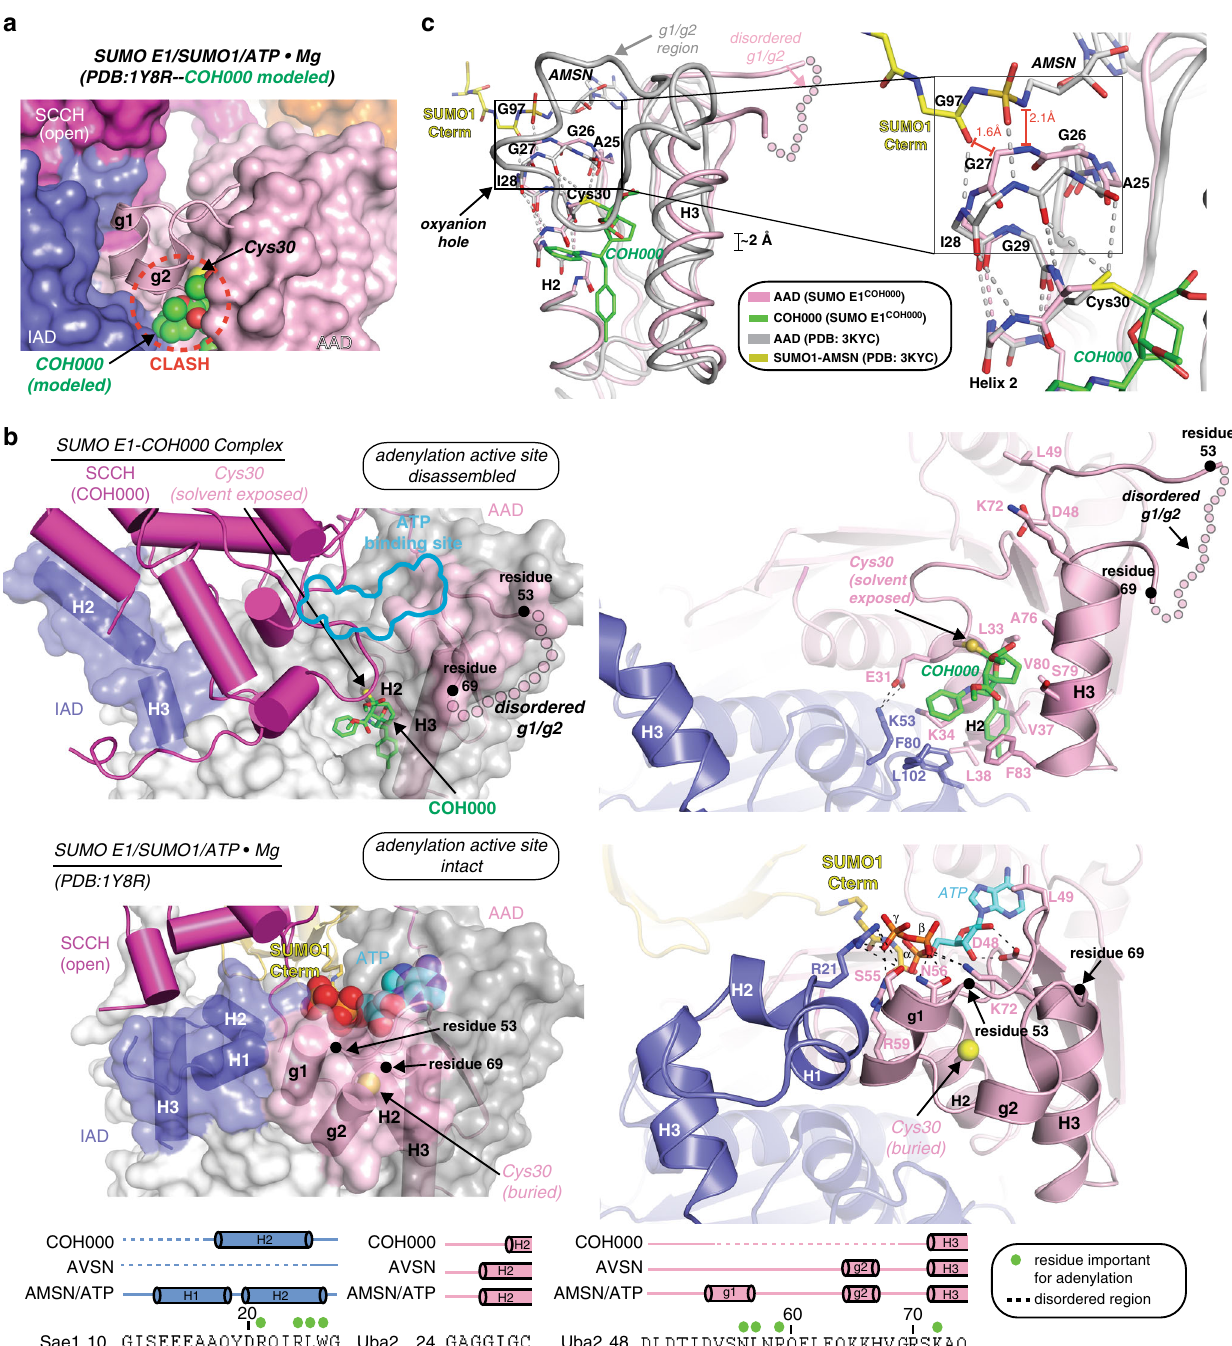
Fig. 3 Small- and large-scale conformational changes are induced in SUMO E1 upon COH000 binding. a COH000 (spheres) was docked onto SUMO E1 from the SUMO E1/SUMO1/ATP (cid:129) Mg structure (PDB: 1Y8R). SUMO E1 is shown as a surface representation with the exception of the g1/g2 region, which is shown as cartoon. The steric clash between COH000 and the g1/g2 region is highlighted by a dashed red circle. Two views of the structure, rotated by 90° about the y -axis are presented. b The SUMO E1 COH000 (top) and SUMO E1/SUMO1/ATP (cid:129) Mg (PDB: 1Y8R; middle) structures are shown in the same orientation to highlight conformational changes that occur upon COH000 binding. Regions undergoing conformational changes are colored by their domain as in Fig. 1a and the rest of the structure is colored light gray. For clarity, the SCCH domains are not shown in the magni fi ed views presented in the right panels. b (bottom) Structure-based sequence alignment of SUMO E1 active site regions undergoing conformational changes upon COH000 binding. Secondary structure for the indicated structures are shown above the sequence colored with dashed lines indicating disorder. Residues important for catalysis of adenylation are highlighted by green circles. c (left) The adenylation domains of the SUMO E1 COH000 and SUMO E1/SUMO1-AMSN (PDB: 3KYC) structures were superimposed and are shown as colored light pink and gray tubes, respectively. AMSN is an adenosine analog harboring a sulfamide group that was used to generate a nonhydrolyzable mimic of the SUMO1-adenylate intermediate 27,39 . The N-terminal half of AAD H2 is shown as sticks and the oxyanion hole is boxed. The 2Å shift of H3 induced upon COH000 binding is indicated and the disordered g1/g2 region of the SUMO E1 COH000 structure is shown as semitransparent light pink circles. The C terminus of SUMO1 (yellow) and AMSN (gray) are shown as sticks. c (right) Magni fi ed view around the SUMO E1 oxyanion